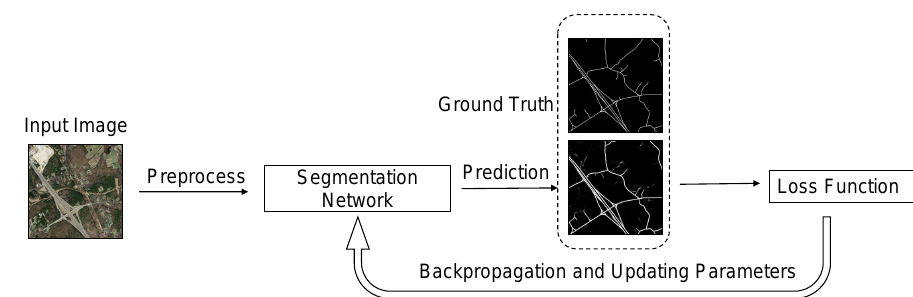
Figure 1. A general scheme of training the deep segmentation